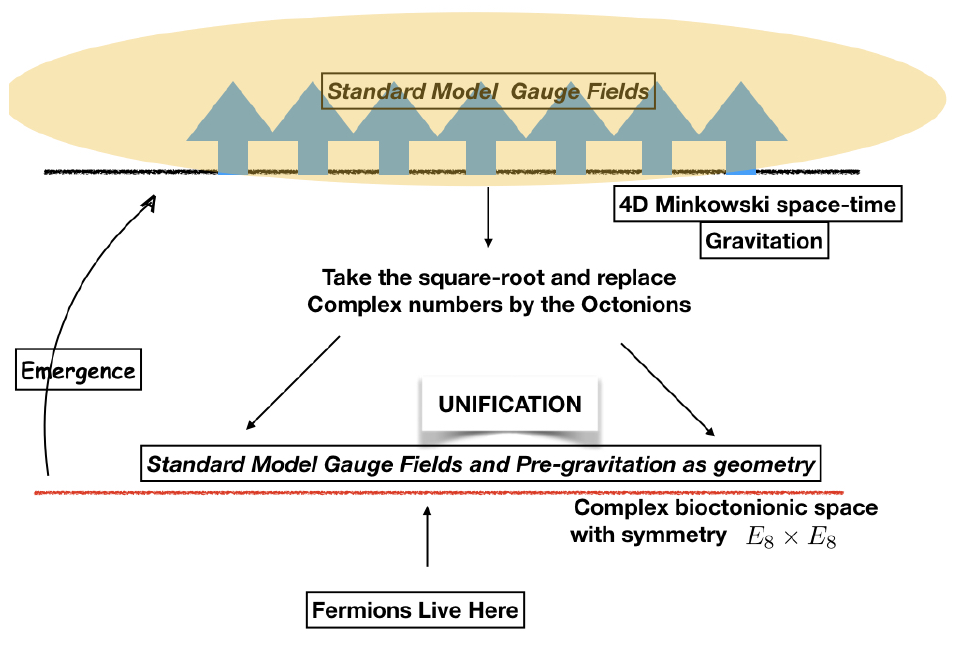
Figure 6. Taking the square-root of 4-dimensional (4D) Minkowski space-time paves the way to